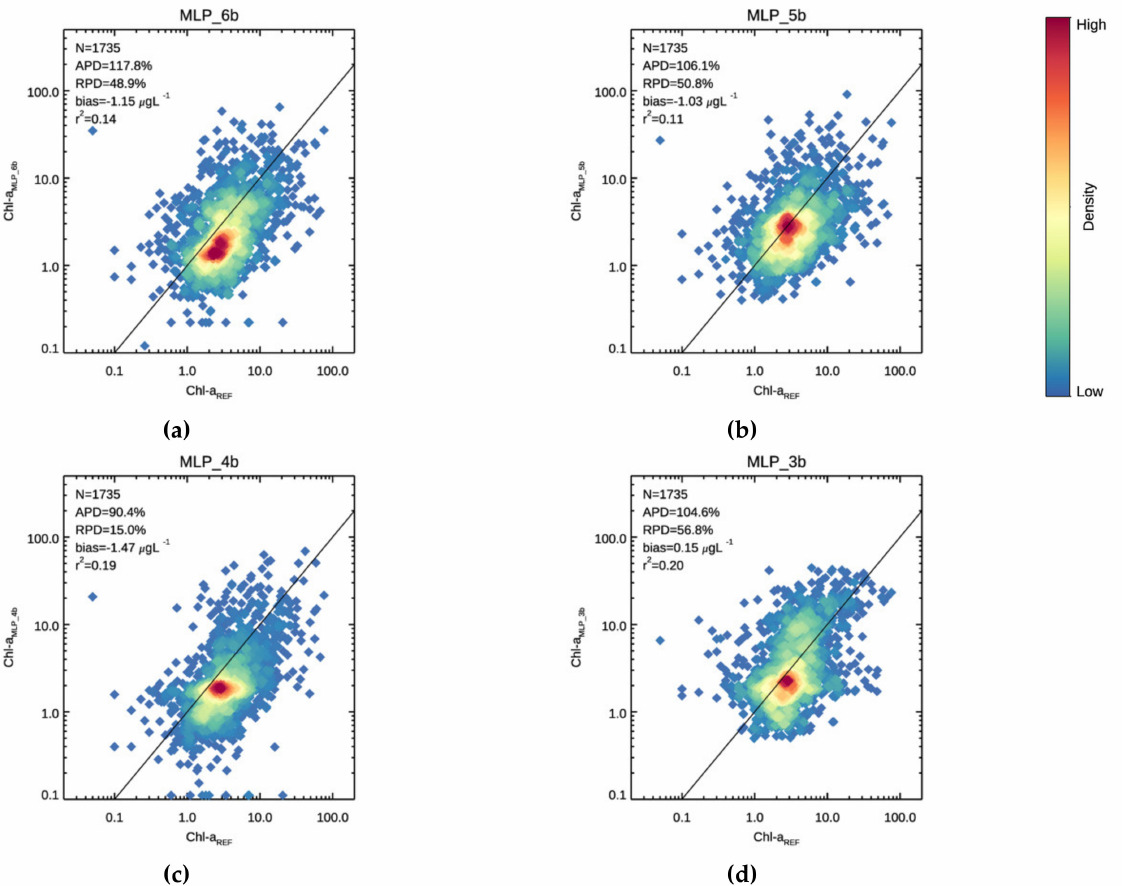
Figure 4. Scatterplots of the satellite-derived and in situ Chl-a co-located observations for the individual MLP candidates. Data points are color-coded by density. The continuous line represents the 1:1 ratio. ( a ) Chl - a MLP _6 b : 6 bands with R rs values at 412, 443, 490, 510, 555, and 670 nm, ( b ) Chl - a MLP _5 b : 5 bands with R rs values at 443, 490, 510, 555, and 670 nm, ( c ) Chl - a MLP _4 b : 4 bands with R rs values at 490, 510, 555, and 670 nm, and ( d ) Chl - a MLP _3 b : 3 bands with R rs values at 490, 510, and 555